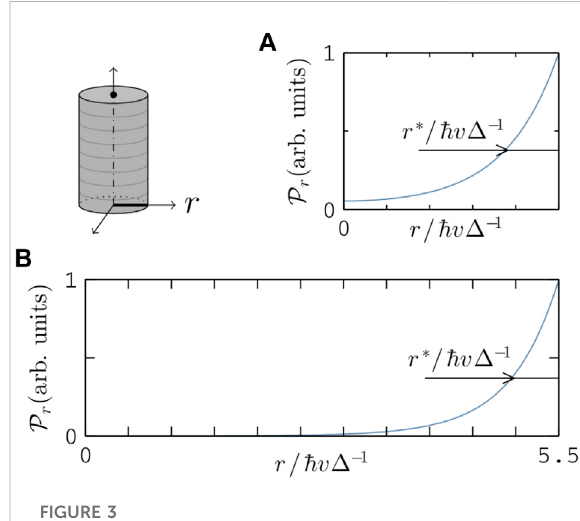
FIGURE 3 Radial probability density of a surface state of | j | = 1/2 in two uniform nanowires of (A) R = 2.5 Z v / Δ and (B) R = 5.5 Z v / Δ . The estimated radial localization length is indicated in both panels as r */ Z v Δ − 1 .